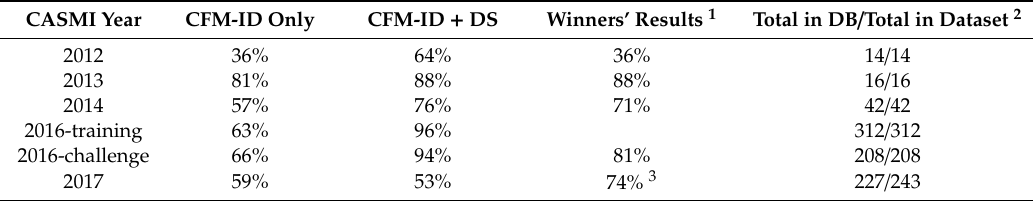
Figure 3. Percentage of challenge compounds from each CASMI dataset ranked in the top (number 1) position by in silico MS / MS match only, Data Source Count (DS) only, and the combined score of in silico MS / MS data with Data Source Counts. Table 2. Percentage of the total number of compounds from each CASMI contest year that were ranked in the top 5 by Competitive Fragmentation Modeling for Metabolite Identification (CFM-ID) only and by the summation of CFM-ID and DSSTox Data Source Counts (DS), alongside the percentage in the top 5 reported by the contest years’ winning entry. Complete ranking results are provided in Supplemental File